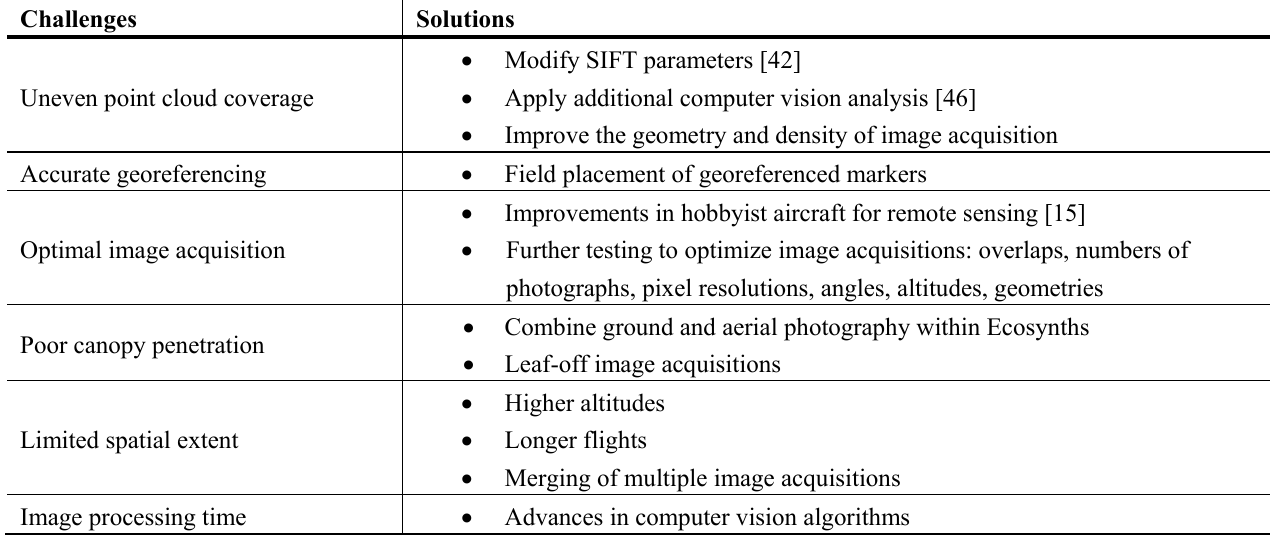
Table 4. Ecosynth: challenges and potential